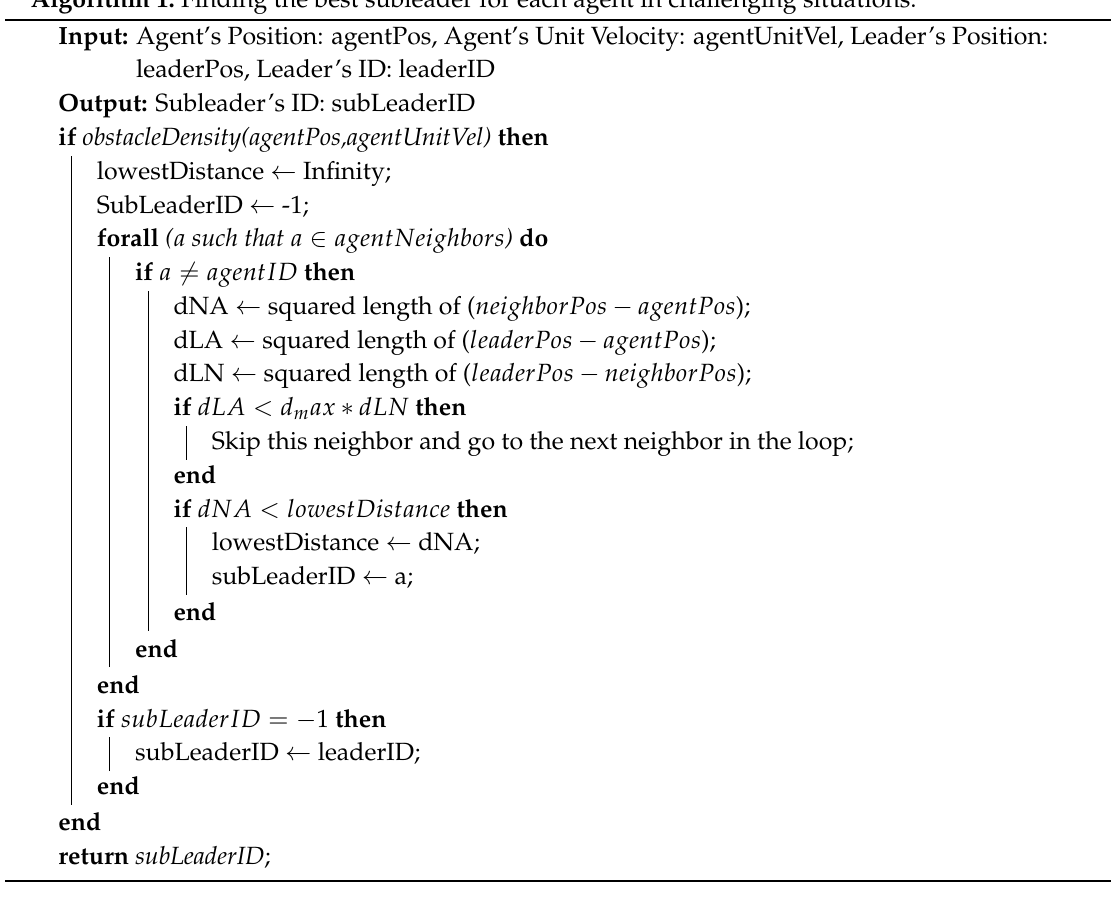
Algorithm 1: Finding the best subleader for each agent in challenging